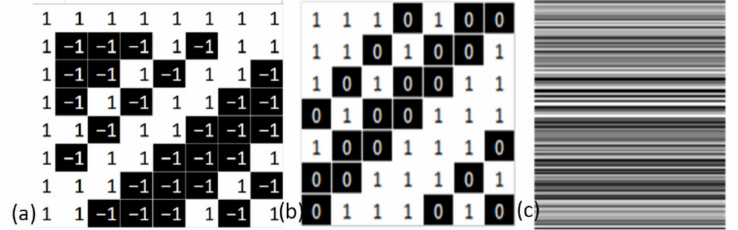
Figure 3. ( a ) Examples of the Hadamard matrices of size 8 derived from the quadratic residue construction is adopted here. ( b ) illustrates the corresponding cyclic binary of the Hadamard matrix. ( c ) shows an example aperture code that has been utilized in this work. Note that each column of the CA follows the pattern of a column (or row) of a cyclic binary Hadamard matrix. In a practical implementation, this pattern would replace the slit of a conventional pushbroom spectrometer; its width would be a few millimeters and the narrowest feature (transparent row surrounded by opaque rows or opaque row surrounded by transparent rows) would be the same size as a detector pixel (a few microns up to a few tens of